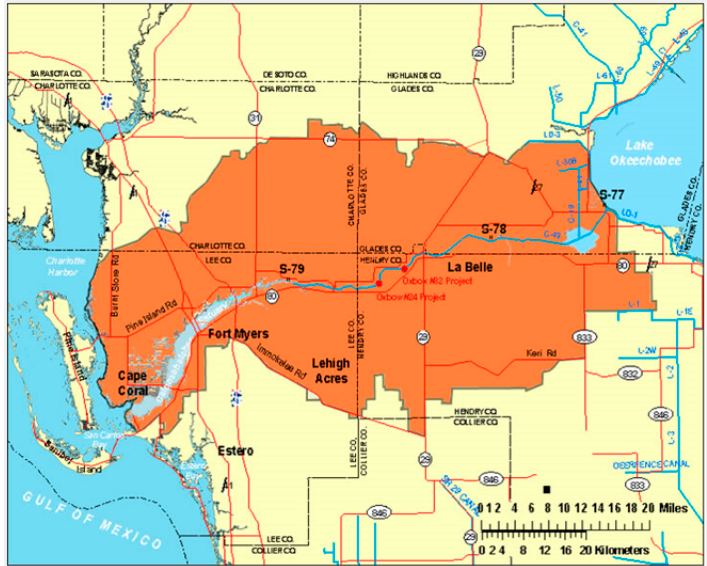
Figure 4. Map showing the location of the C-43 reservoir, Lehigh Acres and the MAR wells are located along the western boundary of the reservoir south of SR-80. They run in a north-south orientation at the boundary between the Lee and Hendry counties (from the U.S. Army Corps of Engineers).